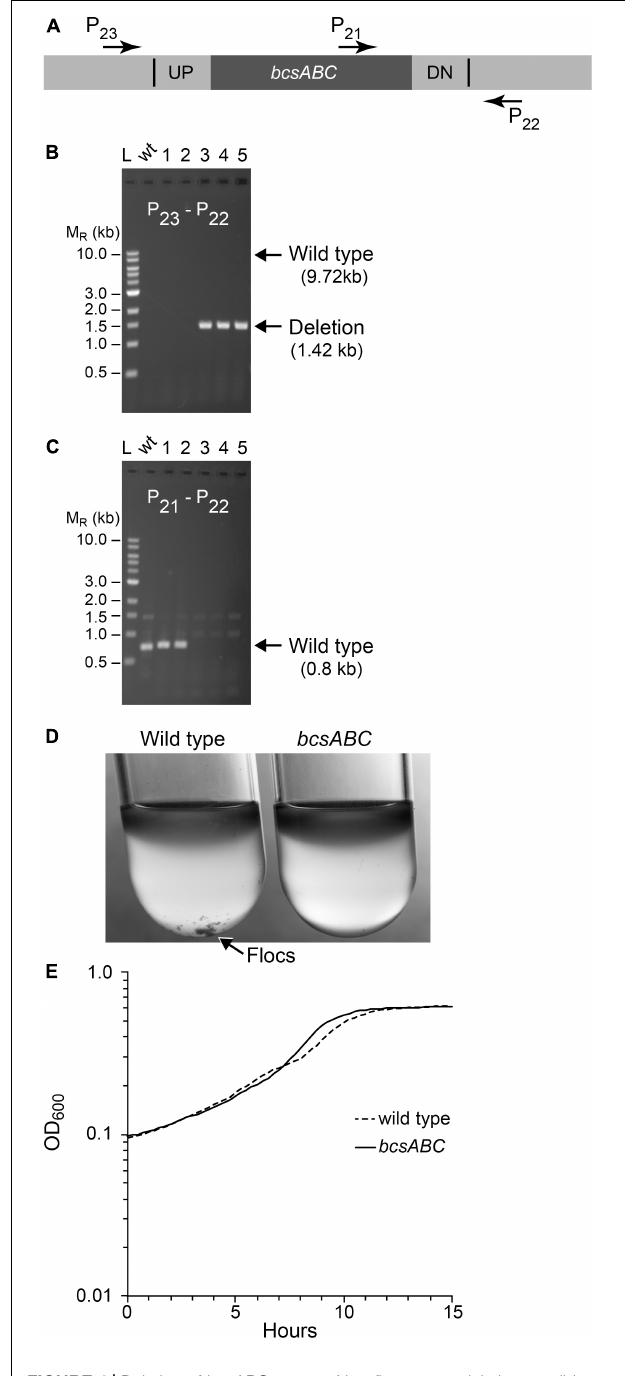
FIGURE 4 | Deletion of bcsABC operon. Non-fluorescent deletion candidates for bcsABC were isolated using the same workflow as outlined for ldh and screened for deletions or wild-type (wt) alleles by PCR amplification. (A) The location of primers used to distinguish between the wt and the deletion genotype is indicated by arrows. (B,C) Agarose gel electrophoresis of products from PCR amplification of five non-fluorescent candidate colonies. (B) Amplification using primers P 22 and P 23 yielded a DNA fragment of 1.4 kb for the deletion of bcsABC (three total), while wt cells are expected to produce an amplicon of ∼ 10 kb, which was poorly amplified under our reaction